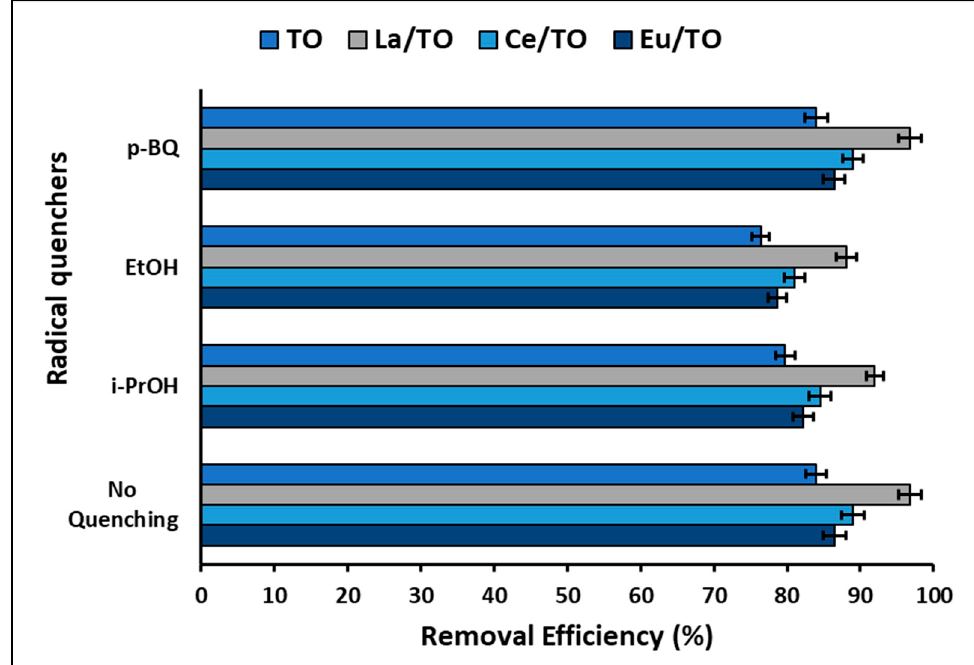
Figure 12. Photogenerated radical quenching experiments.